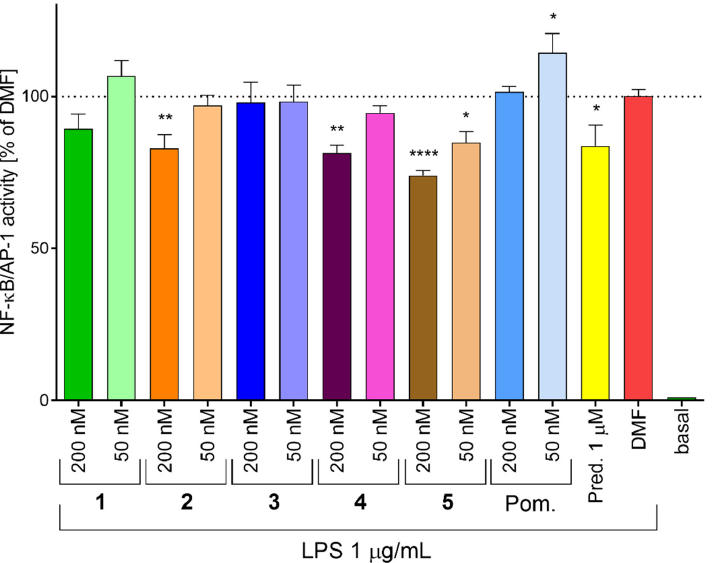
Figure 6. The effect of complexes 1 – 5 on the activity of transcription factors NF- κ B and AP-1. THP-1-XBlue TM -MD2-CD14 cells were pre-treated by the complexes, pomiferin (Pom.) or prednisone (Pred.) dissolved in 0.1% DMF at indicated concentrations for 1 h. Then, lipopolysaccharide (LPS) was added to trigger the NF- κ B/AP-1 activation. The activity of NF- κ B/AP-1 was determined using QuantiBlue™ assay 24 h after LPS stimulation. Graph represents mean values of three determinations ± SEM. The dotted line shows the value of 0.1% DMF treated group. * indicates statistical significance ( p ≤ 0.05) to 0.1% DMF treated group; ** indicates statistical significance ( p ≤ 0.01) to 0.1% DMF treated group; **** indicates statistical significance ( p ≤ 0.0001) to 0.1% DMF treated group.